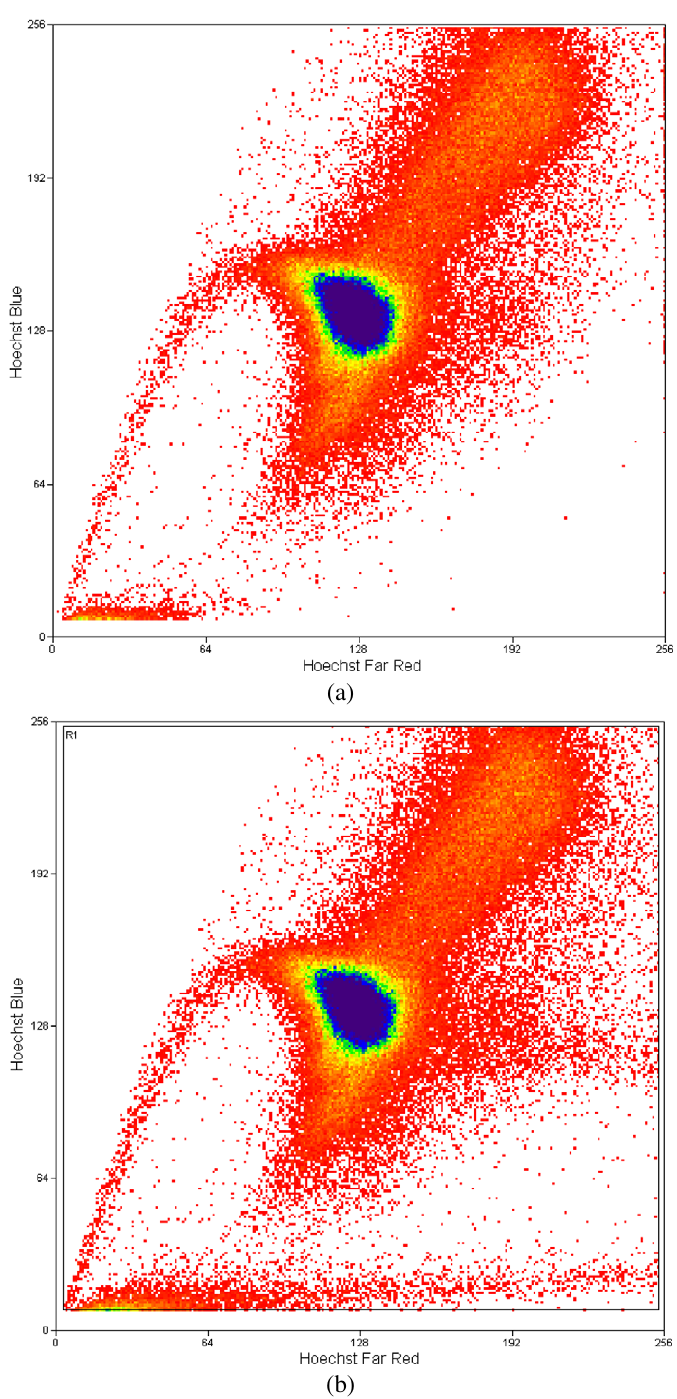
Fig. 4. Representative analysis of the SP using an alternative photomultiplier to discriminate dead cells in human bone marrow samples. Propidium iodide was excited at 488 nm and its emission was measured through the following filter combination: 605 DSP, 718 DSP, 650 DSP and BP 630/30 (a). Side Population analysis using the UV laser for PI excitation, where PI fluorescence was collected using the same photomultiplier as the one used for Red-Ho342 emission